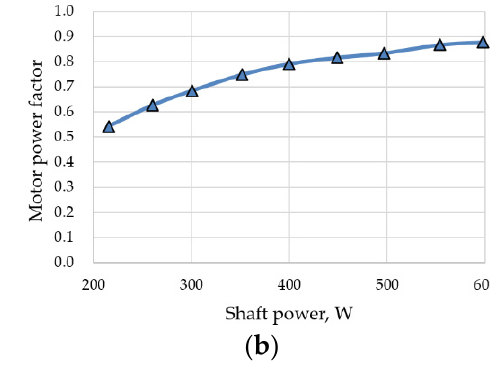
Figure 5. Experimental results: ( a ) motor current; ( b ) motor power factor.